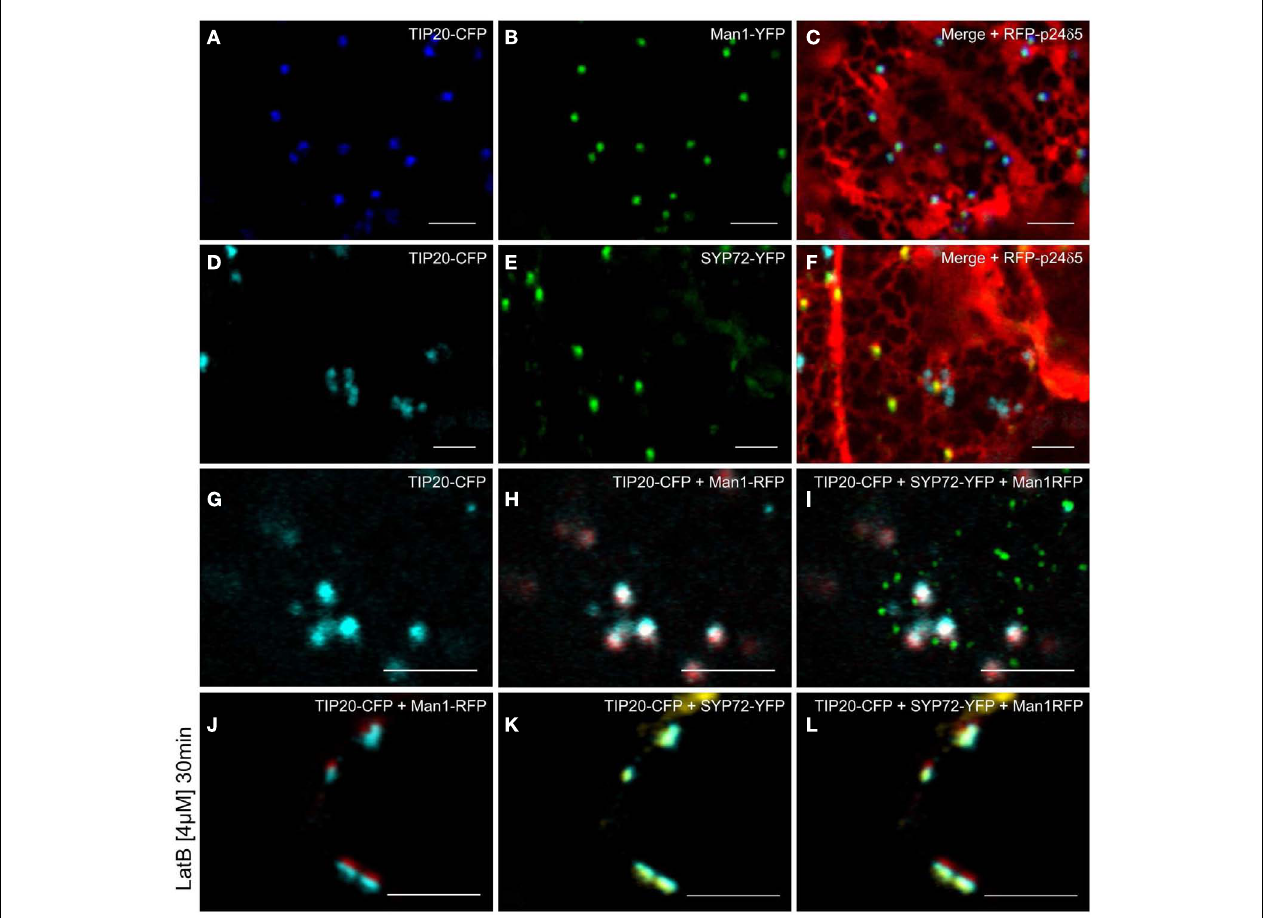
RFP-p24 δ 5 (F) .Triple infiltration ofTIP20-CFP, Man1-RFP, and SYP72 was observed in untreated (G–I) and latrunculin B (4 µ M, 30min) treated cells (J–L) . Magnification bars = 5 µ